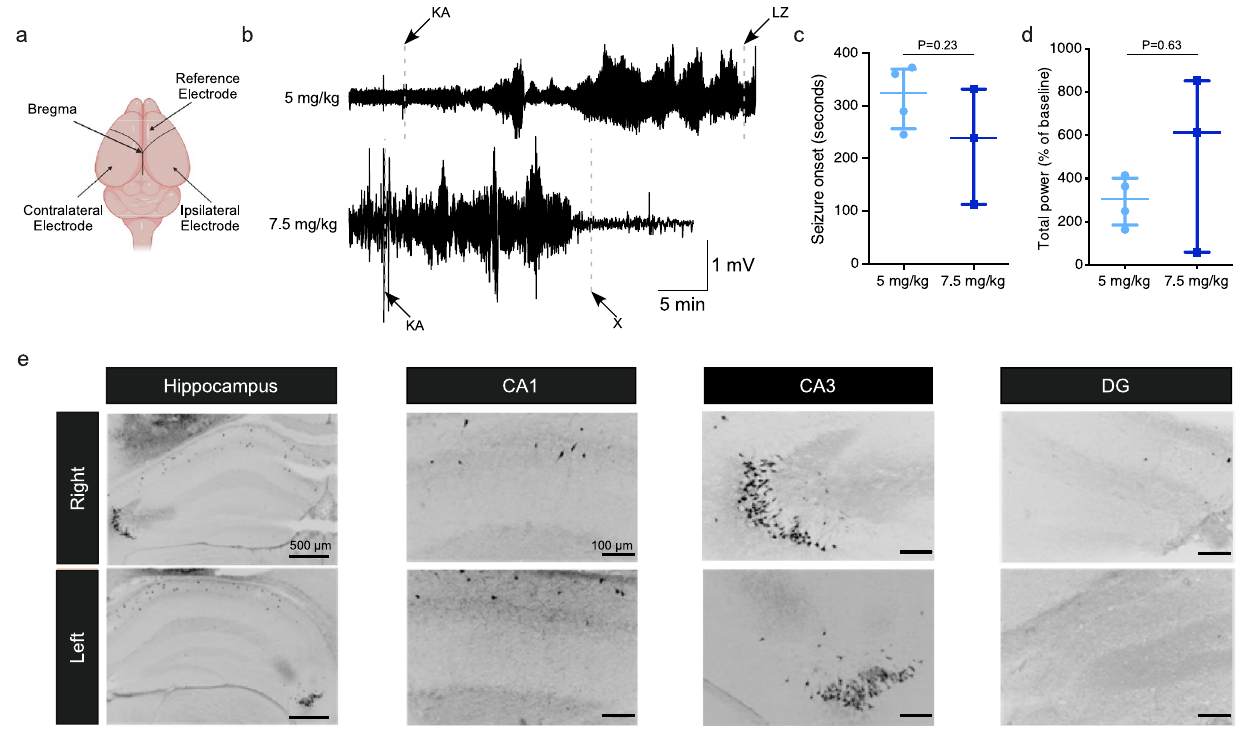
Figure 2. KA dose selection for the induction of seizures in P21 mice. ( a ) Schematic of electrode placement in P21 mouse brain. ( b ) Representative EEG traces for mice injected with 5 or 7.5 mg/kg KA (KA—KA injection, LZ—lorazepam injection, X—mouse died). ( c ) Graph shows no difference in onset to first electrographic seizure after the IP injection of 5 (N = 4) or 7.5 (N = 3) mg/kg of KA. ( d ) Graph shows no difference in % of increase in EEG total power, relative to baseline, recorded over the 30 min after KA injection. ( e ) Representative images of FJB staining show neuronal death at 24 h post SE (5 mg/kg KA) in the right and left hippocampi of a P21